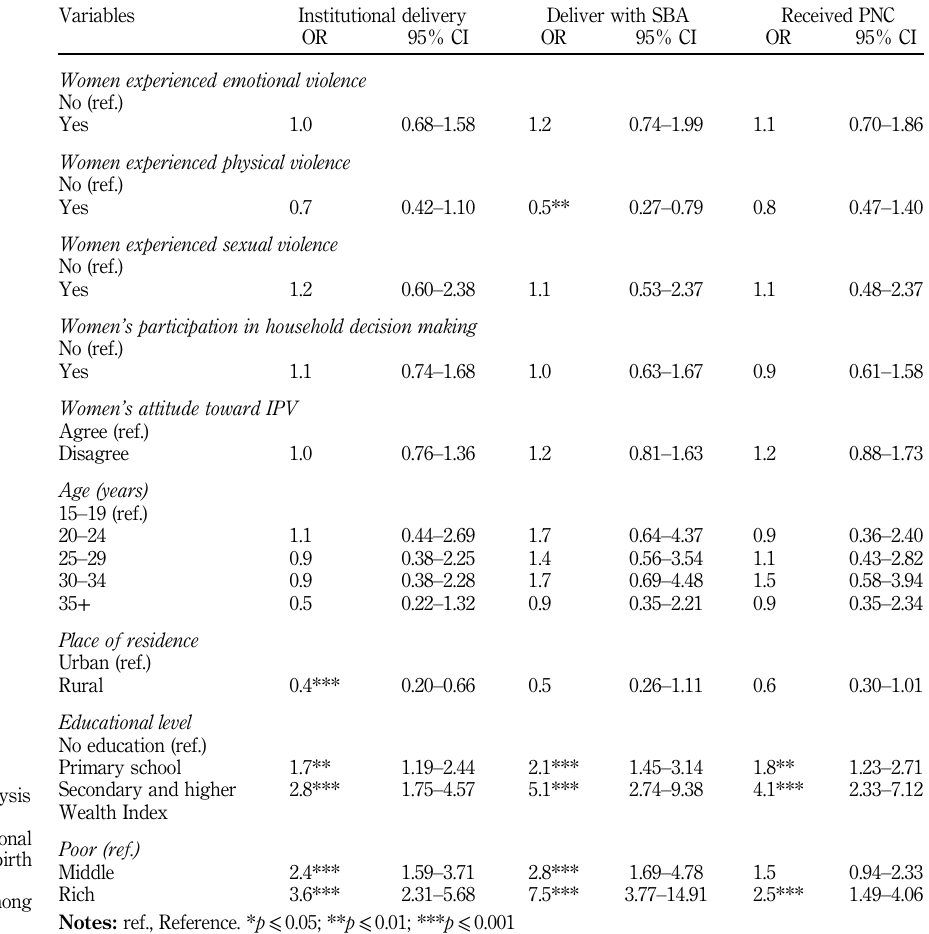
Table IV. Multivariate